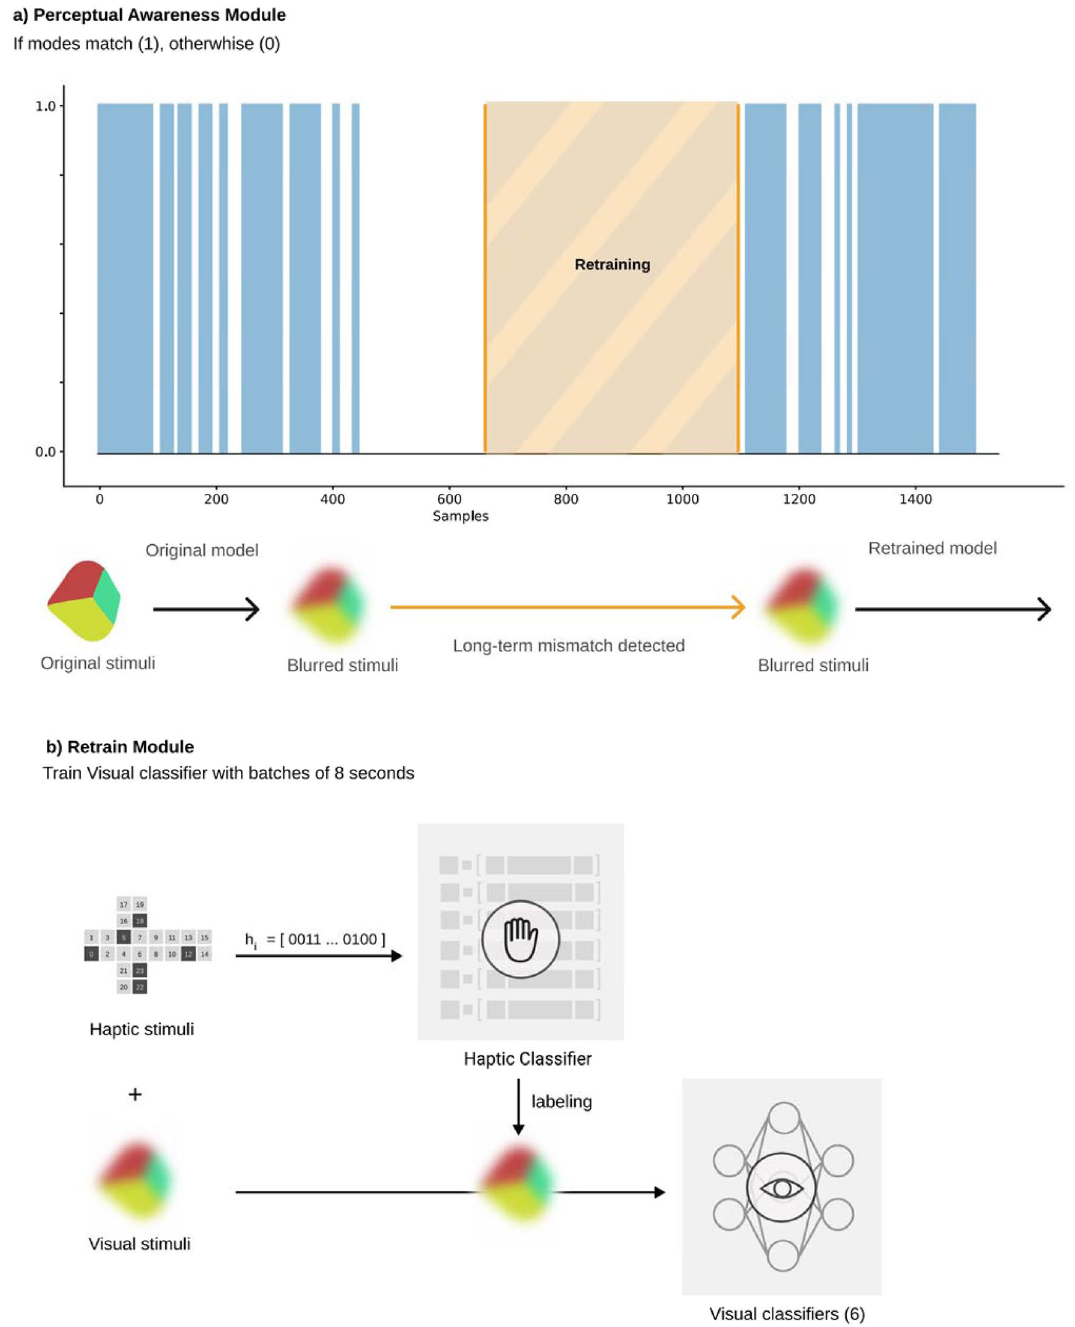
Figure 6. Perceptual awareness and retraining modules. ( a ) The Perceptual Awareness Module is responsible for checking whether the classification incoherence of the modes is short or long-term. If a long-term mismatch is detected, then the retraining module is activated. ( b) Since the visual stimulus is now blurred, the visual classifier becomes unstable. On the other hand, haptic recognition remains stable as this mode is not affected. Blurred visual stimuli are relabeled with haptic data and used to retrain the visual